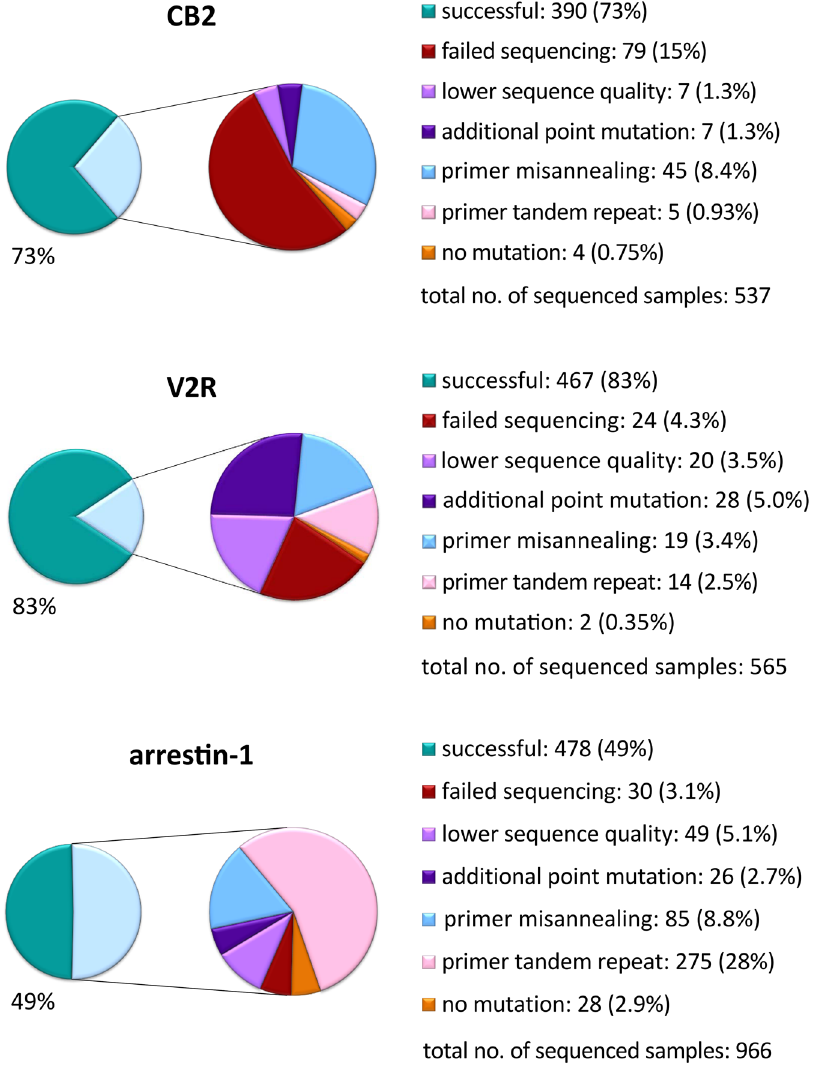
Figure 4. Results of alanine scanning mutagenesis on two G protein-coupled receptors, cannabinoid CB2 receptor (CB2) and vasopressin V2 receptor (V2R) compared with the one-fragment mutagenesis approach used for arrestin-1 (Sun, Ostermaier et al . 13 ). Reason for failure and corresponding percentage within the total number of DNA samples sent for sequencing are given. In case of V2R and arrestin-1, the total number of analyzed samples is smaller than the sum of individual categories as in a few instances several failure reasons could be found within a sequenced sample. Category “failed sequencing” relates to instances with very noisy peaks or no peaks at all in a sequencing electrophoretogram. On the other hand, “lower sequence quality” denotes interpretable sequence traces that had some artefacts or were too short to provide reliable information about success of